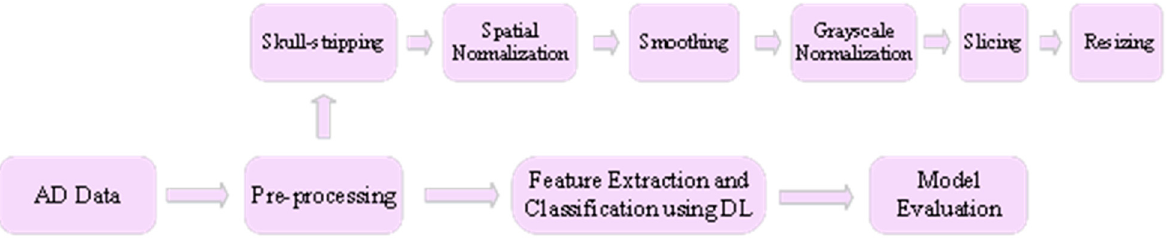
Figure 3. DL-based AD classification